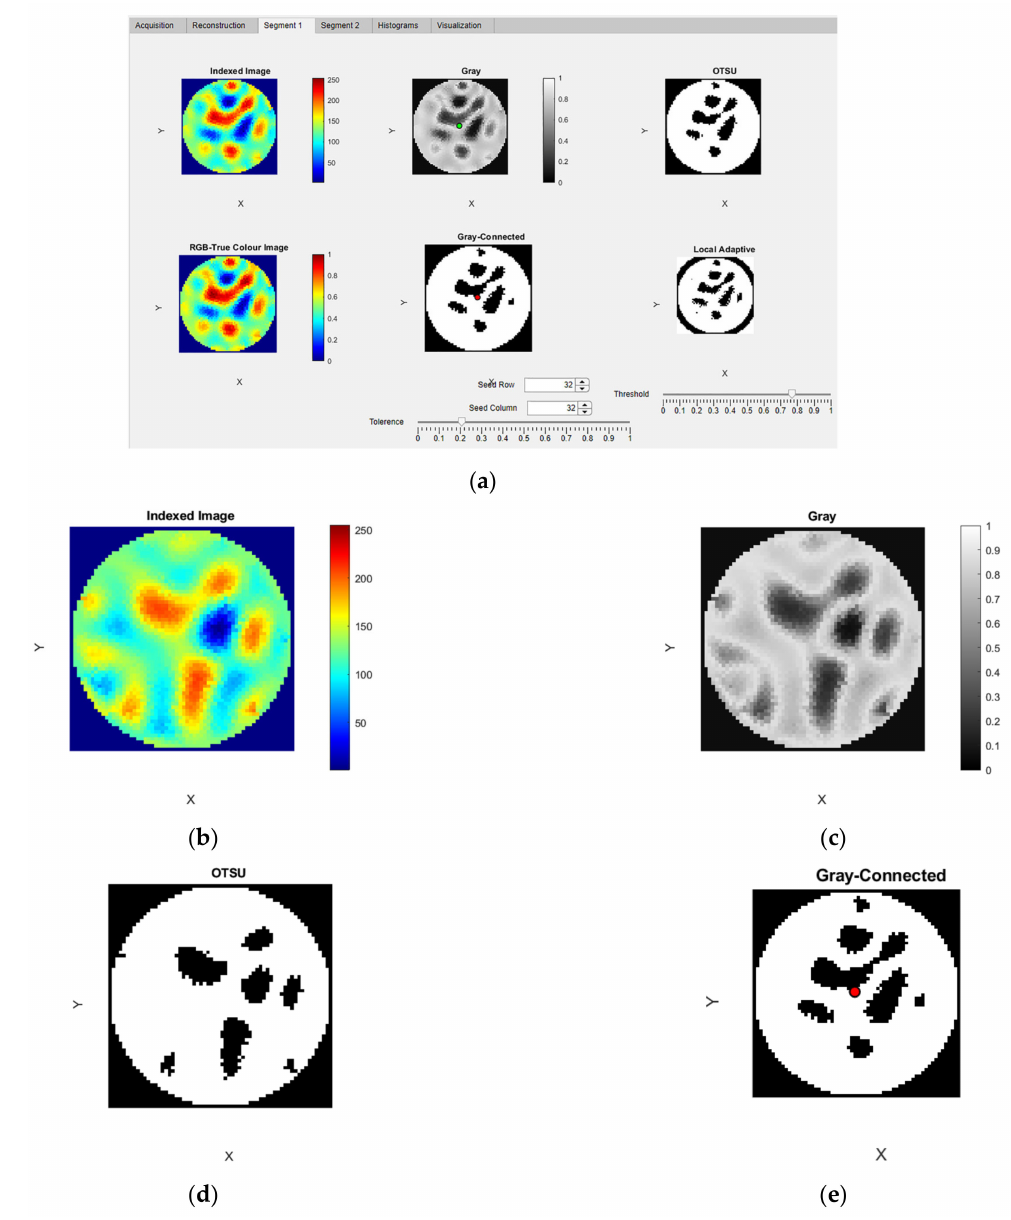
Figure 9. Segmentation module: ( a ) Segment 1 TAB; ( b ) indexed image; ( c ) gray image; ( d ) OTSU- segmented; ( e ) gray-connected segmented image with seed